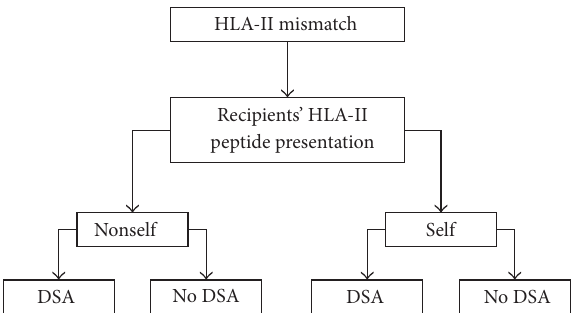
Figure 1: Classification of each HLA mismatch based on the pres- ence of DSA and the nature (self or nonself) of the predicted peptide with highest affinity for the recipient’s HLA class II